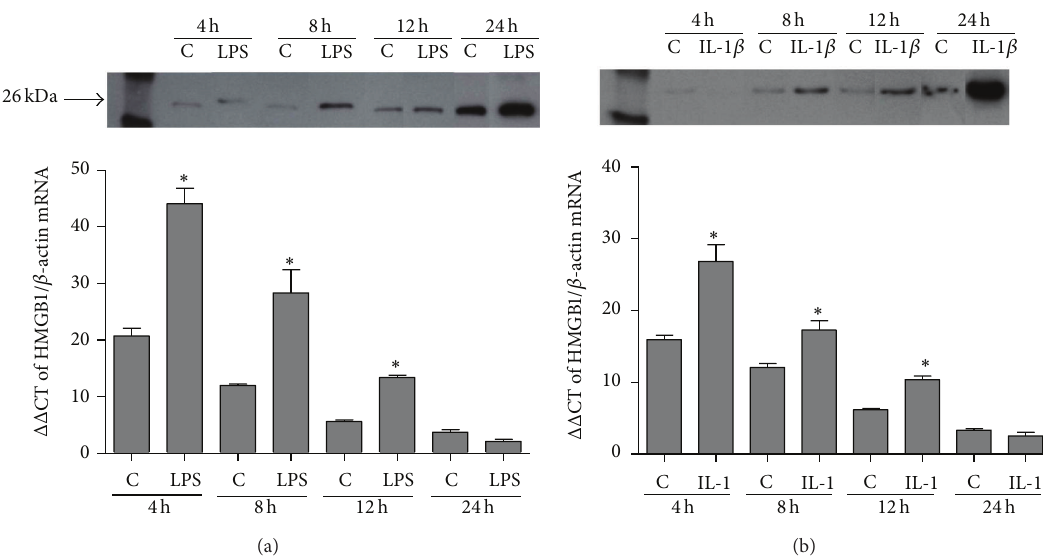
Figure 1: HMGB1 protein release in supernatants from murine periodontal ligament fibroblasts (mPDL) assessed by Western blot after stimulation with LPS ( Escherichia coli ) (a) or IL-1 𝛽 (b) for 4, 8, 12, and 24 hours. HMGB1 mRNA expression assessed by qPCR in MPDL cells after stimulation with LPS or IL-1 𝛽 for 4, 8, 12, and 24 hours. C means control group. ∗ Significant difference compared to control ( 𝑃 < 0.05